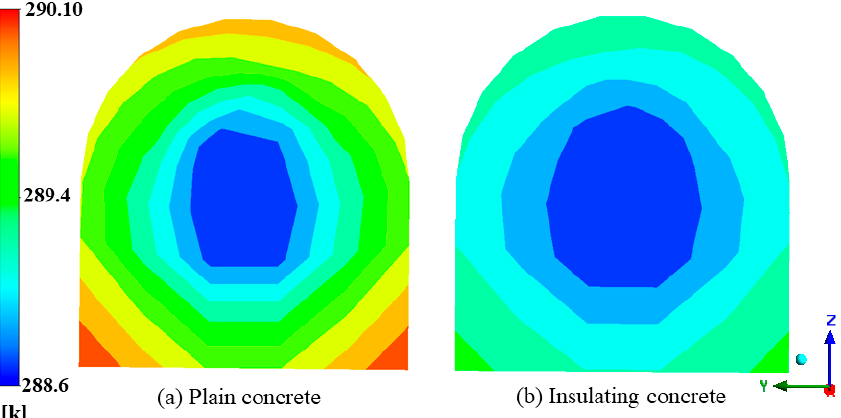
19 of 23 Figure 19. Distribution of convective-heat-transfer coefficients between the wall of the roadway and the wind flow: ( a ) Distribution of convective heat transfer coefficients of the roadway under plain concrete support; ( b ) Distribution of convective heat transfer coefficients of the roadway under in- sulated concrete support. 4.4.3. Airflow Temperature Field at the Outlet The airflow flows out of the section of the concentrated flat lane and enters the air cooler of the mining work surface. If the airflow temperature is low, the cooling power of the air cooler can be reduced, saving energy. Figure 20 shows the temperature field of the exit airflow from the section-concentrated flat lane. We observed that in both cases, there iwass an unheated circular area (flow layer) at the center of the roadway section where the temperature was kept at 288.65 K, and the other areas had higher temperatures closer to the wall. The radius of the flow layer under plain-concrete support was approximately 1.46 m, the average value of wind flow temperature was 289.29 K, and the maximum value was 290.10 K. The radius of the flow layer under-insulated concrete support was approx- imately 2.10 m, the average value of wind-flow temperature was 288.99 K, and the maxi-